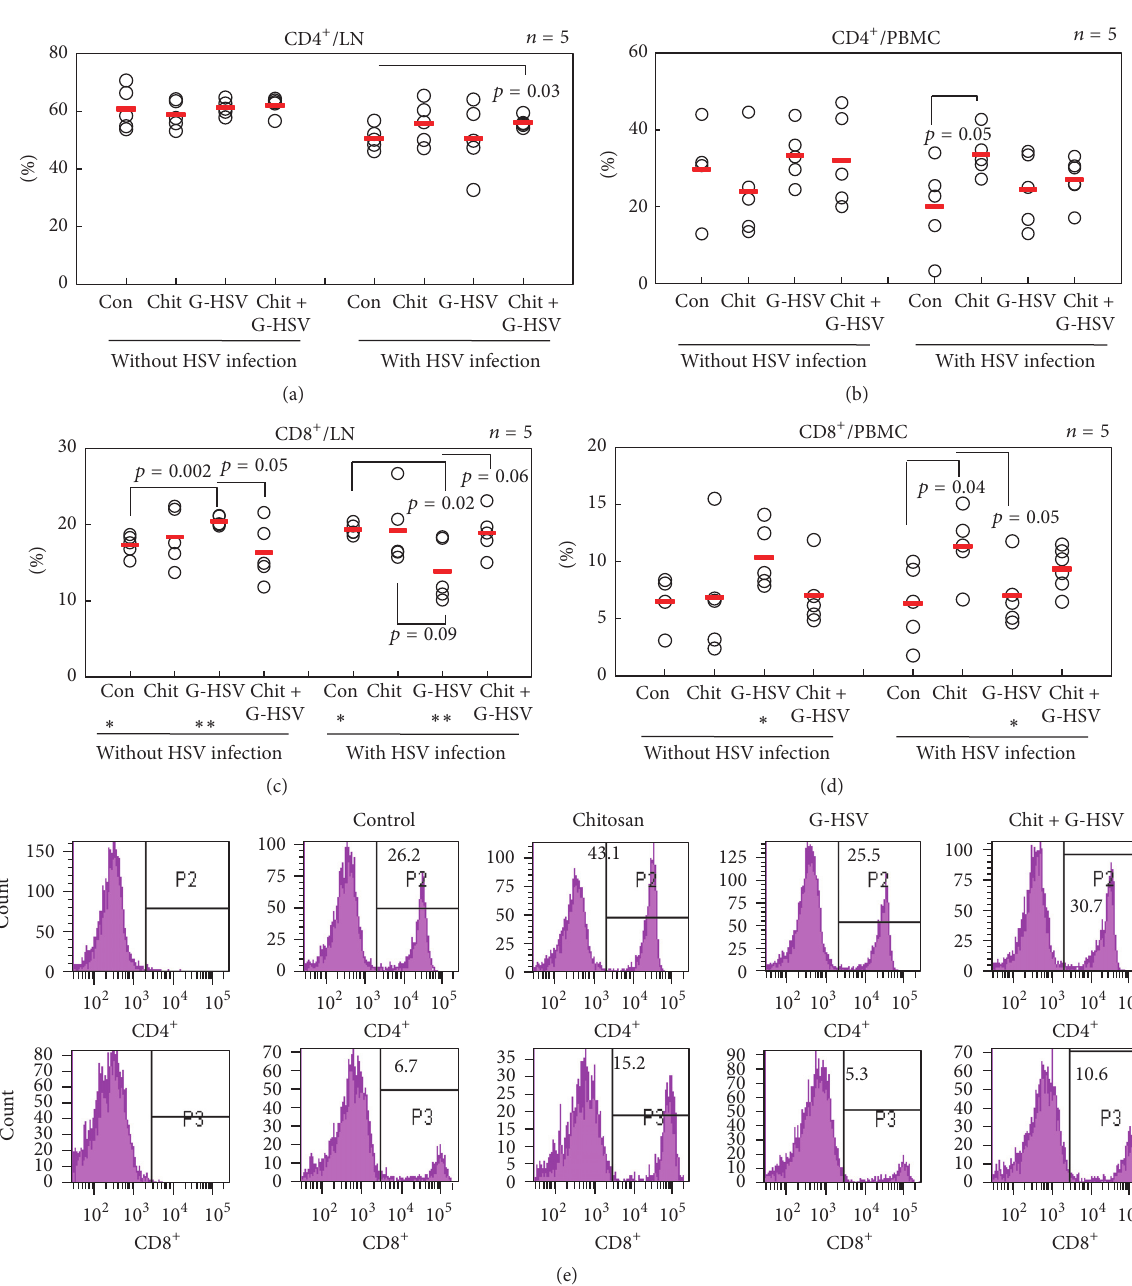
Figure 1: Efficacy of chitosan on CD 4 + and CD 8 + T-cells with or without HSV infection. Administration of 1% acetic acid (control), 0.23% chitosan (Chit), heat inactivated GFP-HSV (G-HSV), or chitosan with G-HSV (Chit+G-HSV) orally into normal mice for three times at 10-day intervals. On the next day, mice were sacrificed or inoculated with HSV-1 at 10 days later as described in the Materials and Methods. Isolated PBMC and lymph node cells were applied for analysis of CD 4 + and CD 8 + T-cells by flow cytometry (a–d). The frequencies of CD 4 + and CD 8 + T-cells in PBMC were significantly upregulated in chitosan treated mice compared to those in control mice infected with HSV. (e) Representative histogram of the frequencies of CD 4 + and CD 8 + cells in HSV infected PBMC. The number of mice used in each group was five. In (c) ∗ 𝑝 = 0.01 and ∗∗ 𝑝 = 0.004 and in (d) ∗ 𝑝 = 0.05